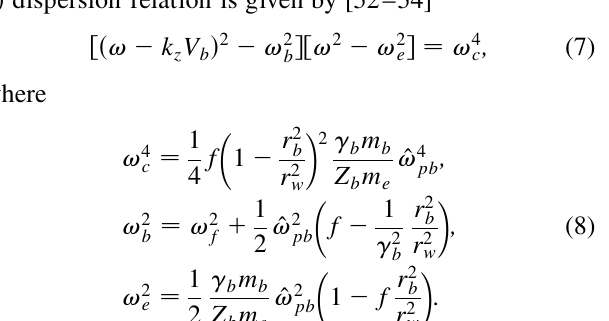
FIG. 4. Time history of perturbed density (cid:31)n spatial location. After an initial transition period, the m (cid:7) 1 dipole-mode perturbation grows